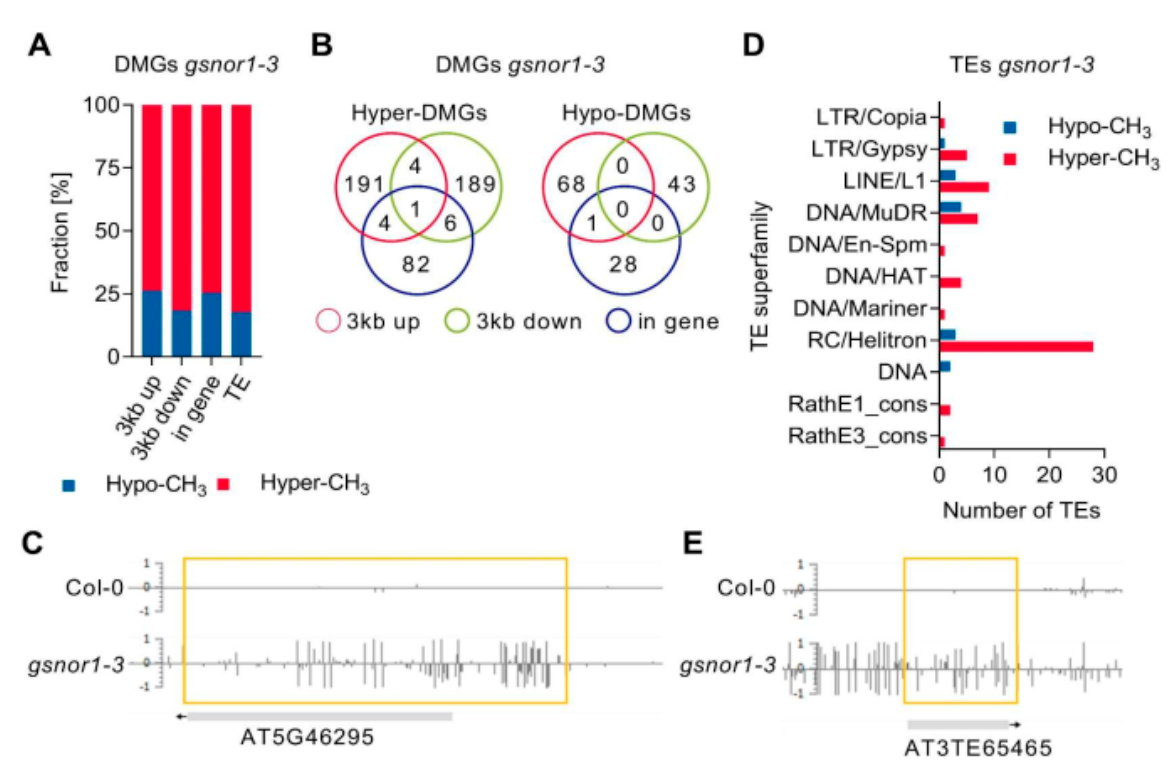
Figure 6. Loss of GSNOR1 function results in an enrichment of hypermethylated DMGs and TEs. ( A ) Stacked bar plot showing the fraction of hyper- and hypo-DMGs and TEs with respected to DMRs found in their genic, 3kb up- or downstream region or TE coding region. ( B ) Venn diagram summarizing DMGs with DMRs in multiple genomic features (genic, 3kb up- and/or downstream flanking regions). ( C ) Snapshot of AT5G46295 in the EPIC-CoGE browser. ( D ) Distribution of differentially methylated TEs over TE superfamilies. ( E ) Snapshot of AT3TE65465 in the EPIC-CoGE browser. DNA methylation data have been uploaded to the epigenome browser of EPIC (EPIC-CoGE) by Prof. Dr. Claude Becker (ID 2234 unpublished). DNA methylation analysis was performed in duplicates, and average methylation ratios calculated in the CoGE browser are shown. TE classification according to www.arabidopsis.org accessed on 24 December